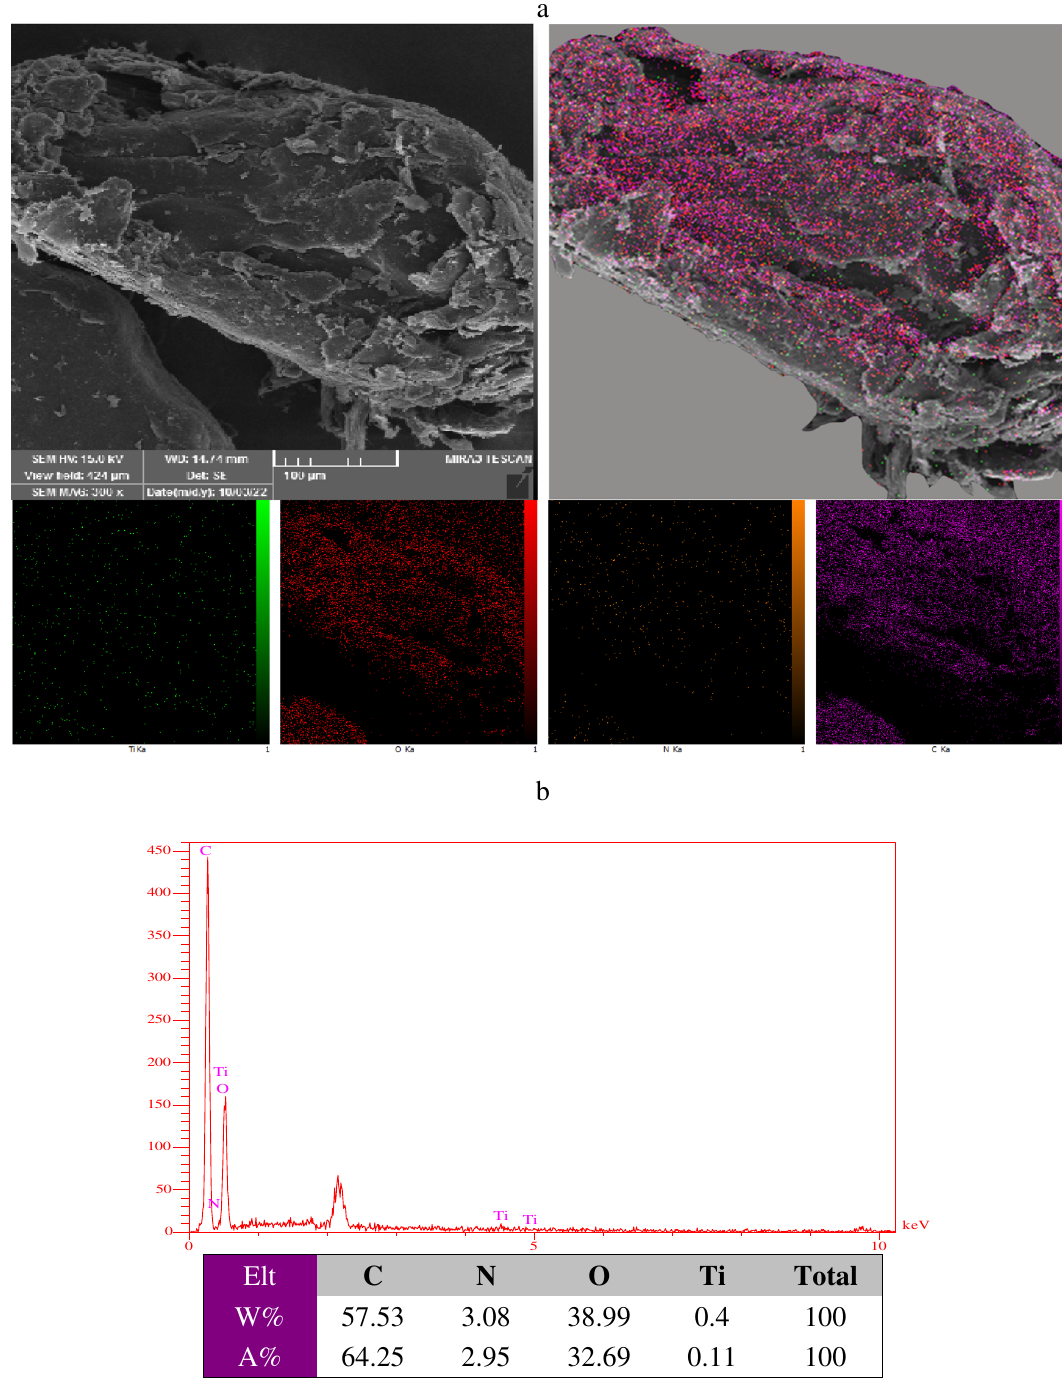
Figure 9. ( a ) The elemental mapping: purple spots (C), orange spots (N), red spots (O), green spots (Ti), ( b ) the EDX spectra and corresponding elemental analysis of = the TiO 2 @PVA